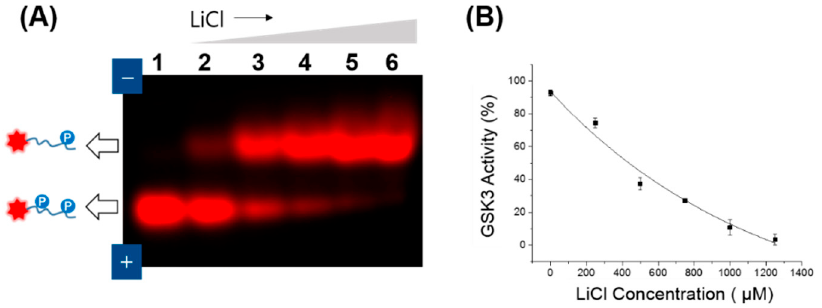
Figure 2. Fluorescent gel shift-based inhibition assay of GSK3 activity as a function of inhibitor (lithium chloride, LiCl) concentration: ( A ) Fluorescent gel image from the GSK3 inhibition assay using LiCl (0 ´ 1.25 mM) in the presence of T-Pep(p). T-Pep(p) was reacted with recombinant active GSK3 at varied concentrations of LiCl: 0 µ M (Lane 1), 200 µ M (Lane 2), 500 µ M (Lane 3), 750 µ M (Lane 4), 1 mM (Lane 5), and 1.25 mM (Lane 6); ( B ) Inhibitory graph of GSK3 activity as a function of LiCl concentration. GSK3 activity (%) was calculated and plotted from the relative fluorescence intensities in the two band regions which corresponded to T-Pep(p) and T-Pep(pp) on agarose, according to Equation (1). The final concentration of GSK3 was 1.25 U in 20 µ L of reaction volume. The standard deviation was obtained from three independent experiments.